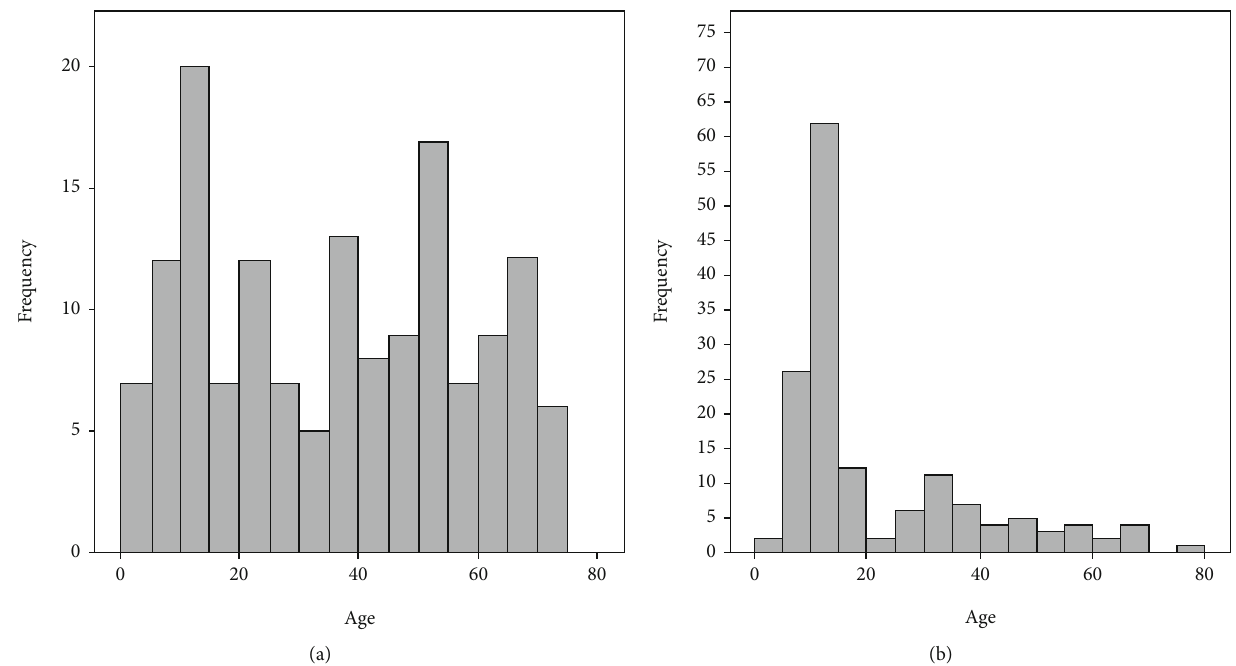
Figure 2: Age distributions of the included clavicular BO (a) and NBO (b)